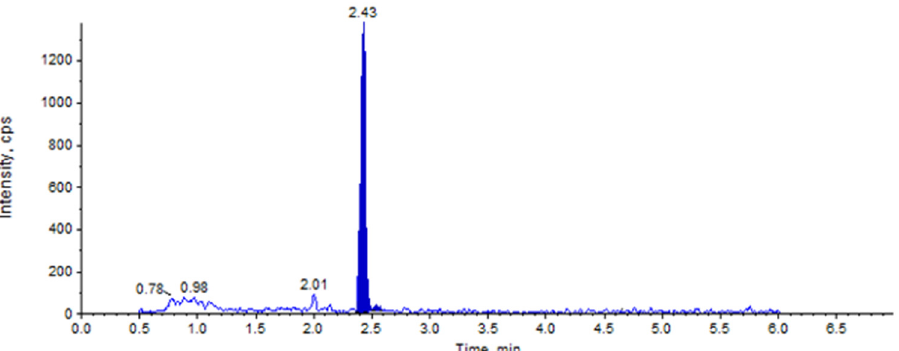
Figure 5. UPLC-MS/MS chromatogram of TTX standard.